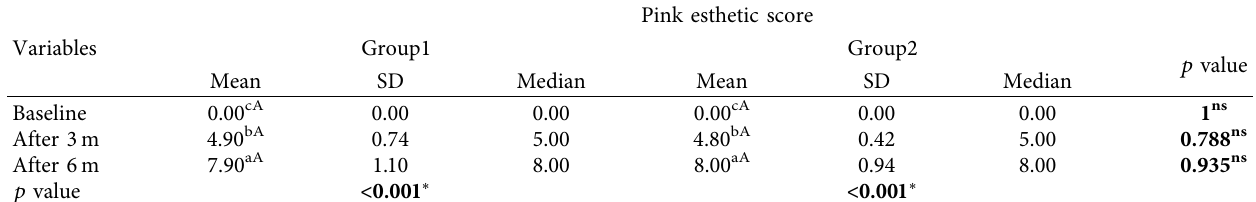
Table 1: The mean and standard deviation (SD) values of pink esthetic score of different groups.